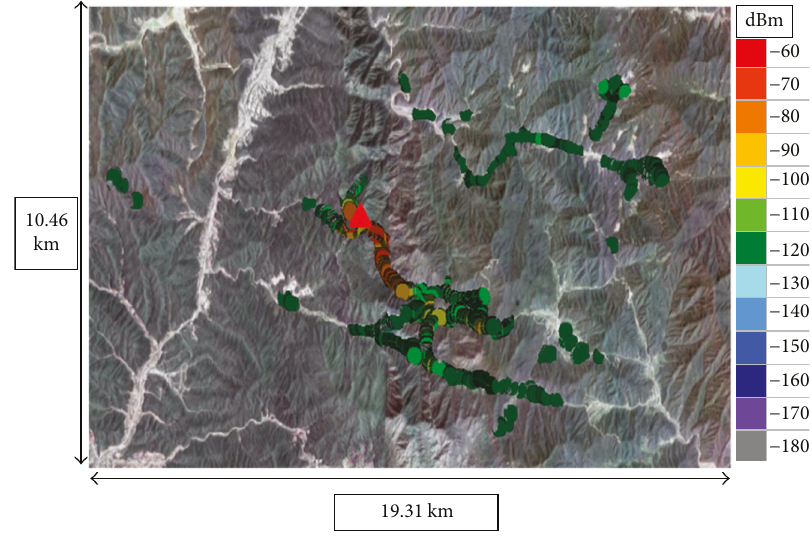
Figure 9: Measurements in the west side of Mt. Maebong.